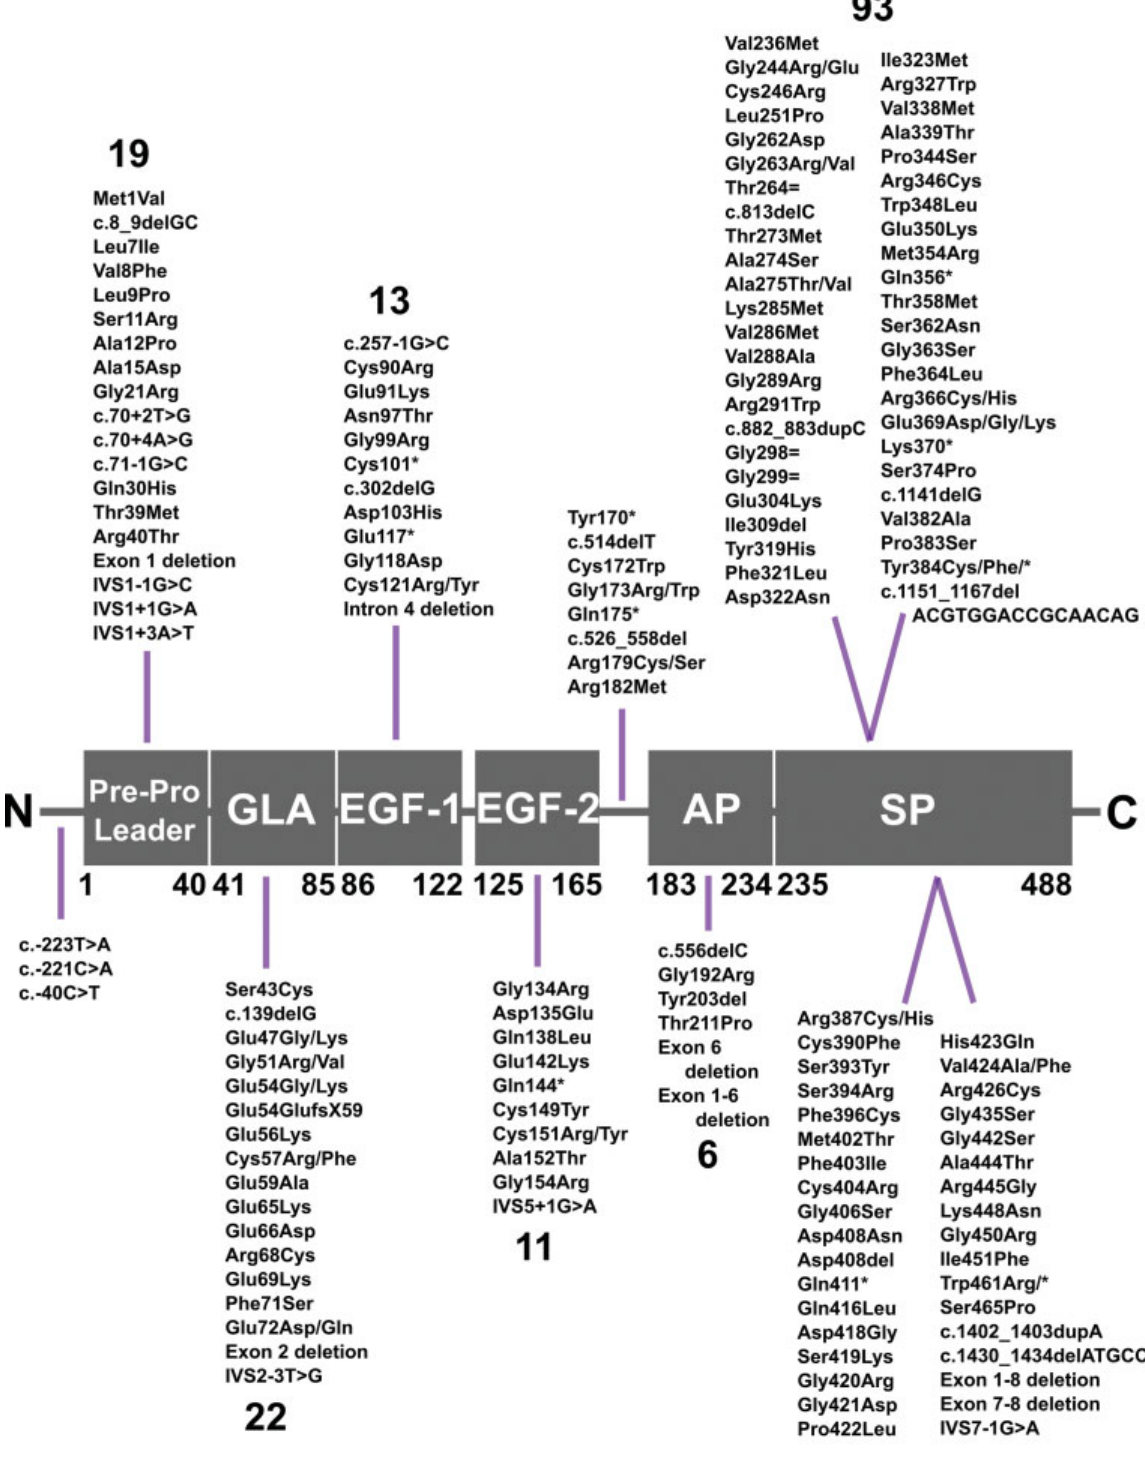
Fig. 1 Distribution of the 180 variants identi fi ed within the F10 gene. The six protein segments are not drawn to scale. The number of variants in each of the respective domains is shown in large font above or below the variant lists. Intronic variants are included in their respective domains according to sequence numbering. The residue numbering under the domains marks the amino acids framing each domain, given in HGVS format. N and C represent the N- and C-termini, respectively, of factor X (FX). Only 177 variants are displayed in this schematic as the remaining variants are unde fi ned insertions and deletions. AP, activation peptide; EGF, epidermal growth factor; GLA, γ -carboxyglutamic acid; SP, serine